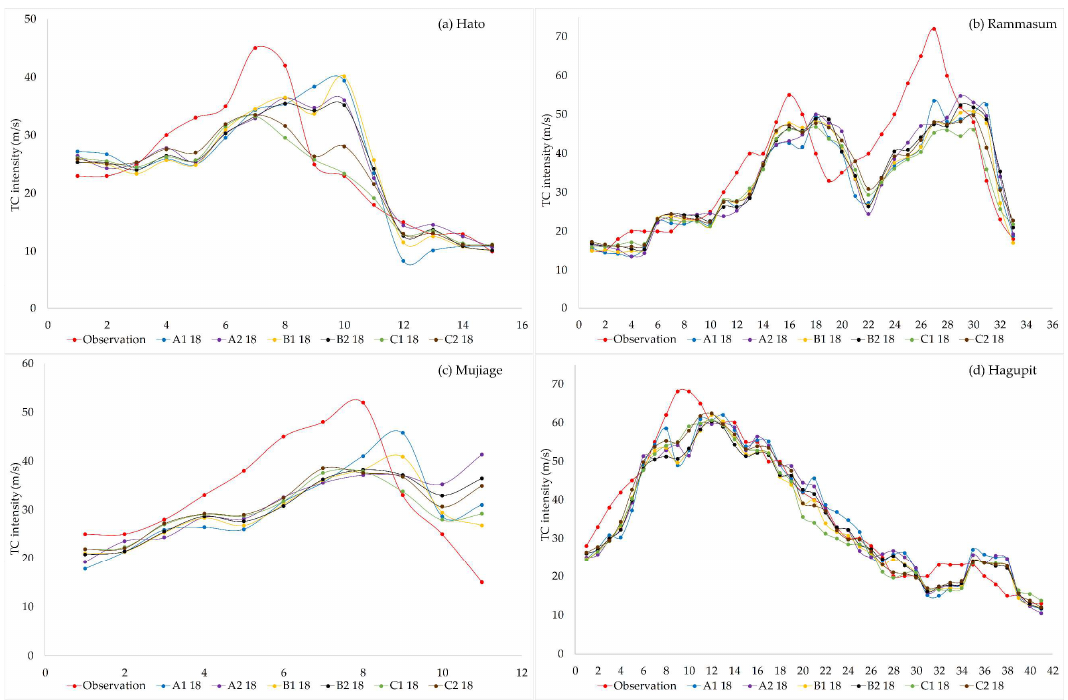
Figure 6. Observed and predicted sequence values of TC intensity with an 18-h lead time for ( a ) Hato, ( b ) Rammasum, ( c ) Mujiage, and ( d ) Hagupit, respectively. The following color coding is used: red (observation), blue (A1, 18 h lead time), purple (A2, 18 h lead time), orange (B1, 18 h lead time), black (B2, 18 h lead time), green (C1, 18 h lead time), and brown (C2, 18 h lead time).